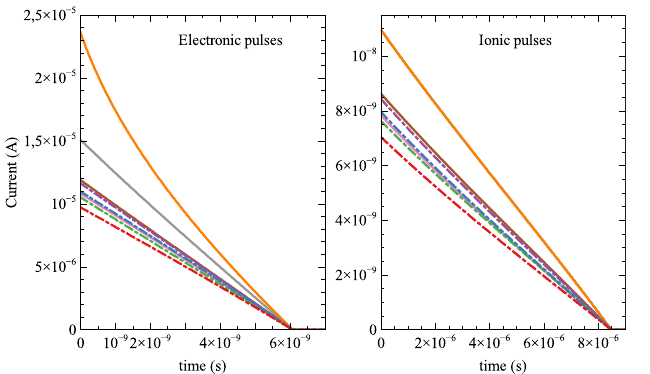
Fig. 12. Left: electronic pulses computed with the CFUR geometry. Right: ionic pulses computed for few fission tracks generated by heavy and light fission fragments.